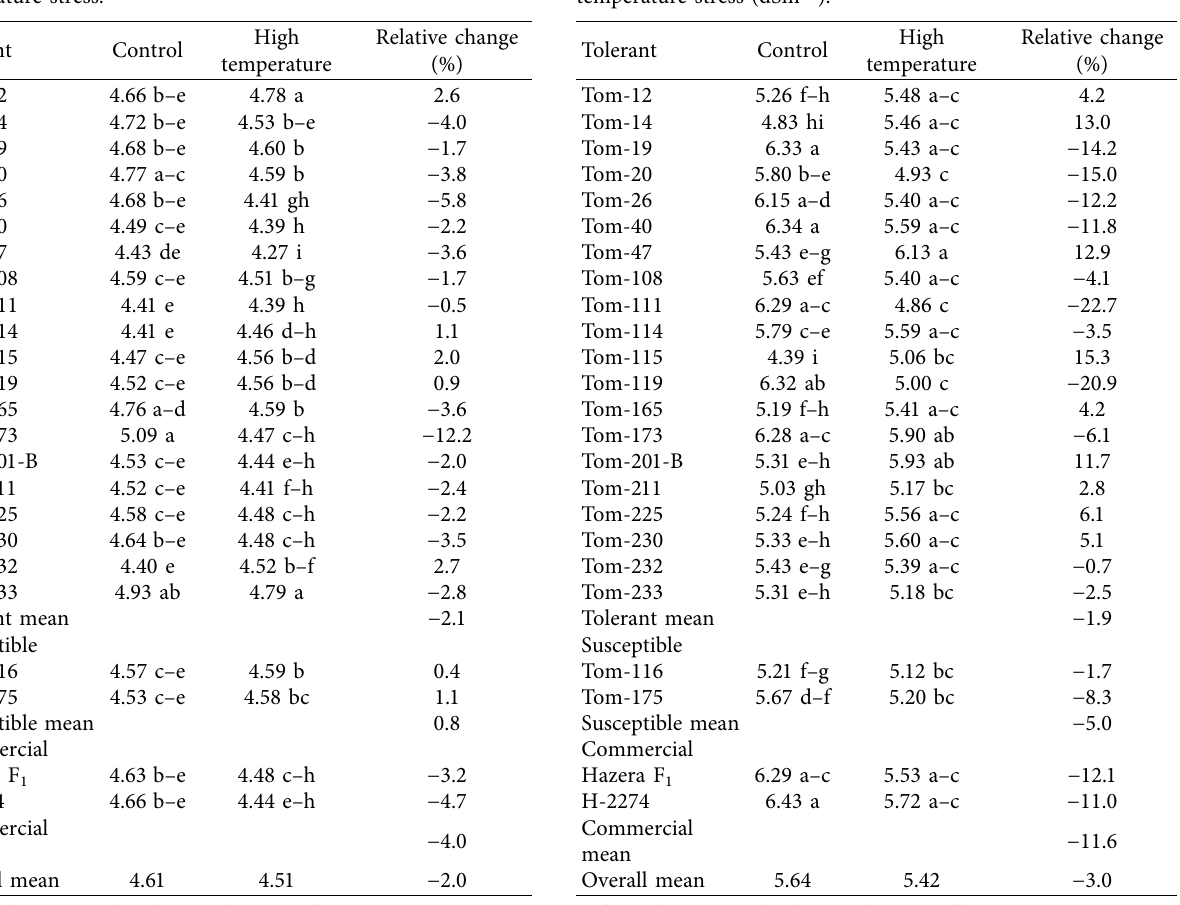
Table 5: pH of tomato fruits grown under control and high- temperature stress.